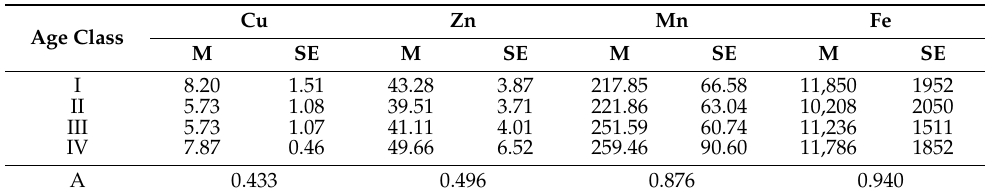
Table 5. Mean (M) with standard error (SE) stocks (kg/ha) of microelements in the top (0–30 cm) soil layer under silver birch regeneration by age class.